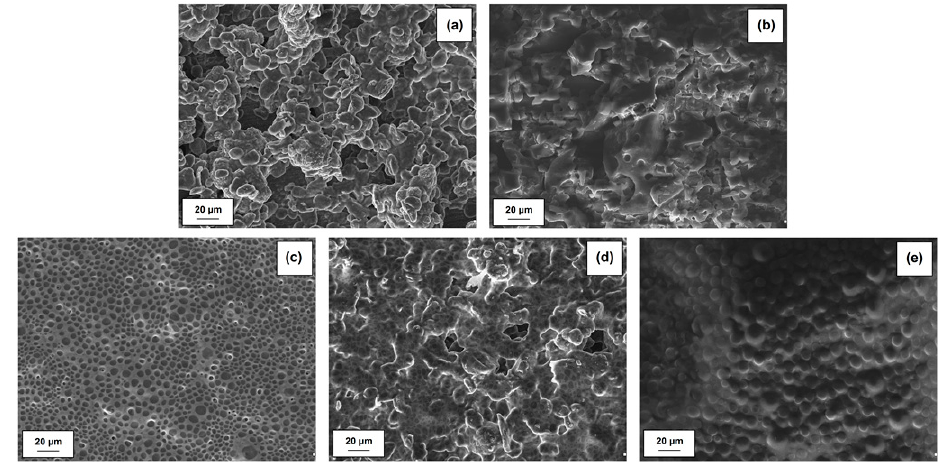
Figure 14. SEM images of electrodes: MnO 2 ( a ), KL ( b ), MnO 2 /KL+A ( c ), MnO 2 /KL+B ( d ) and MnO 2 /KL+C ( e ).